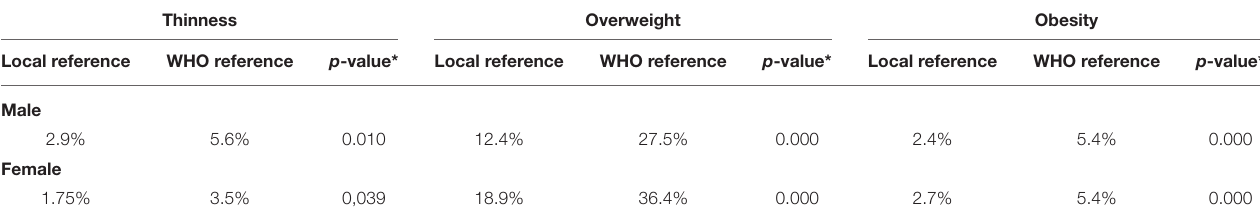
TABLE 3 | Comparison of the proportions of thinness, overweight and obesity obtained with the local references and with the 2007 WHO reference. Thinness